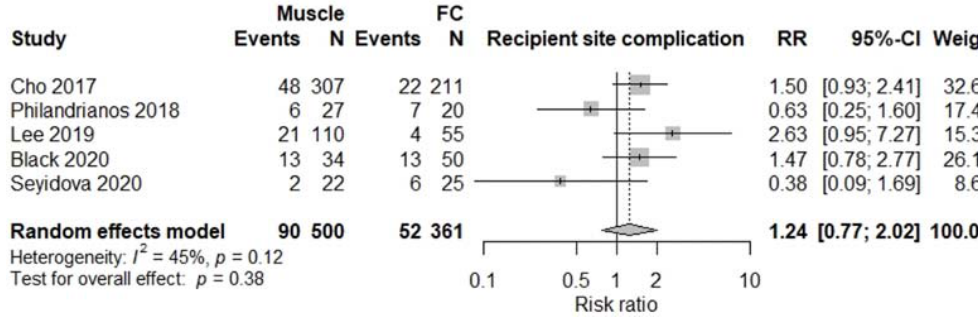
Figure 6. Recipient site complication not implying flap loss.